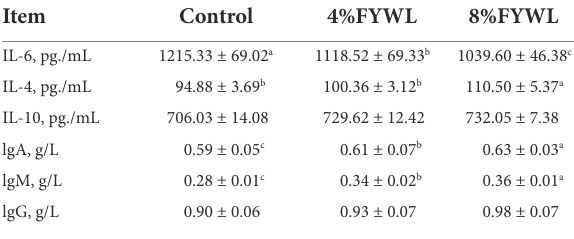
TABLE 5 Effect of FYWL on meat quality of finishing pig.